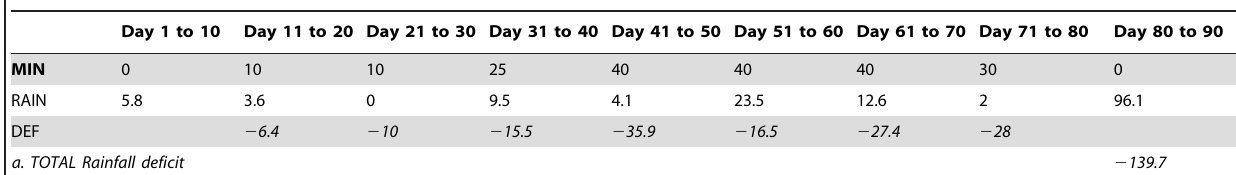
Table 5. Example of season resulting in an indemnity payment (total rainfall deficit exceeds the trigger value of